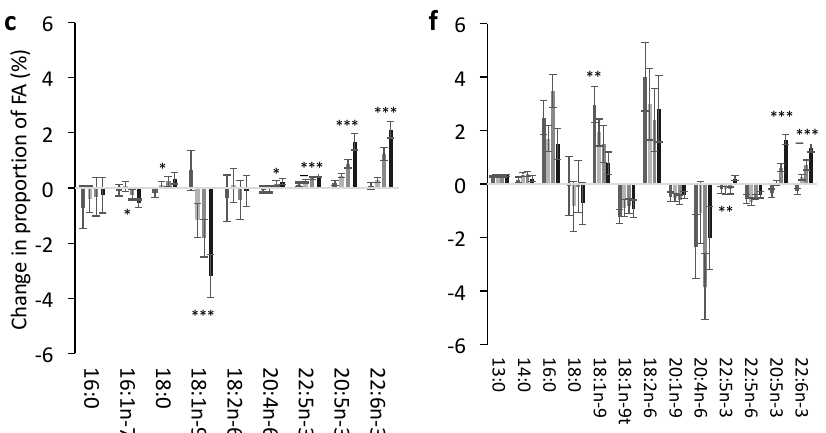
Figure 2. Mean change in key fatty acids in response to 12 months supplementation of EPA + DHA equivalent to 0, 1, 2 or 4 portions of fish per week in different plasma and blood cell pools. The observed mean ± SE change from baseline in the fatty acids identified as important in relation to change in EPA + DHA in the multinomial regression models in ( a ) Plasma PC; ( b ) Plasma CE; ( c ) Plasma TAG; ( d ) RBC; ( e ) PLAT; ( f ) MNC. The effect of dose was tested by linear regression models for each fatty acid. Each model was tested with and without age and sex which were included as covariates if significant. Change in dietary SFA, MUFA, n-3 PUFA or n-6 PUFA where relevant were also tested to determine if change in diet influenced the change in fatty acids with EPA + DHA dose. Significant effects of dose detected in these models are shown as: * p < 0.05; ** p < 0.01; *** p < 0.0001; † Effect of dose ( p = 0.05) only when taking into account the change in dietary n-6 PUFA from baseline to 12 months; ‡ Effect of dose ( p < 0.05) is no longer